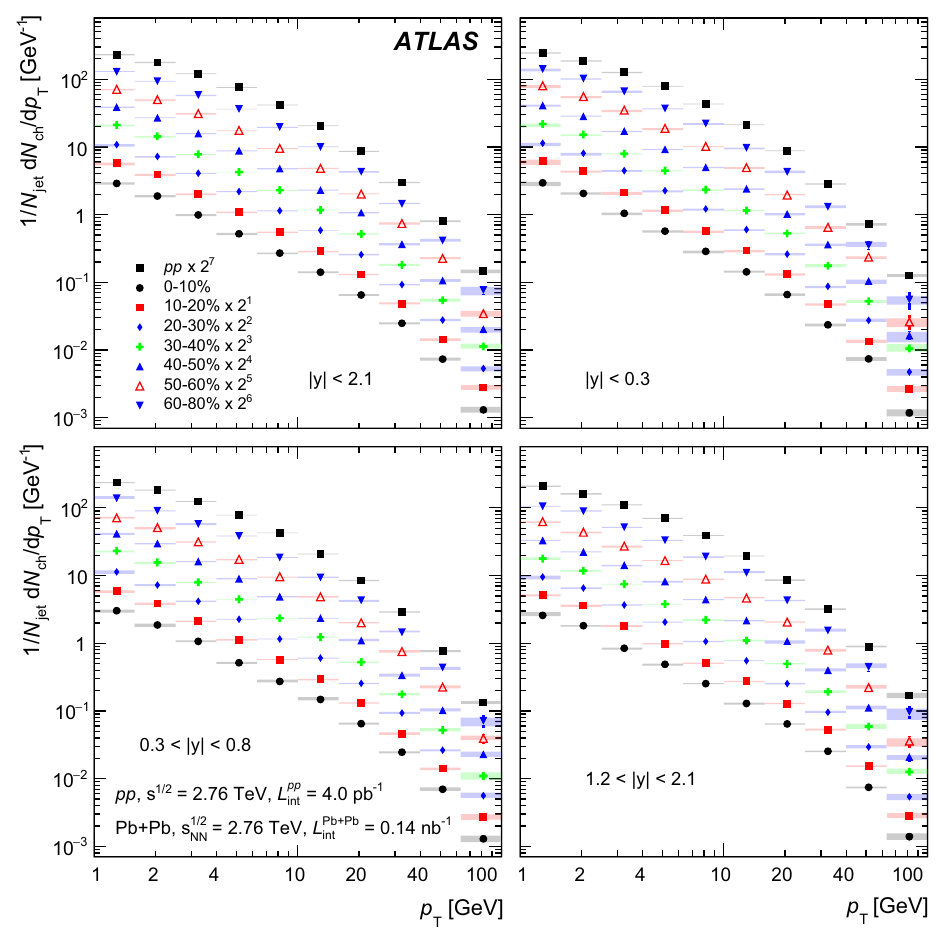
Fig. 2 Unfolded charged-particle transverse momentum distributions, D ( p T ) , measured in pp collisions and for seven centrality bins mea- sured in Pb+Pb collisions. The four panels show D ( p T ) distributions